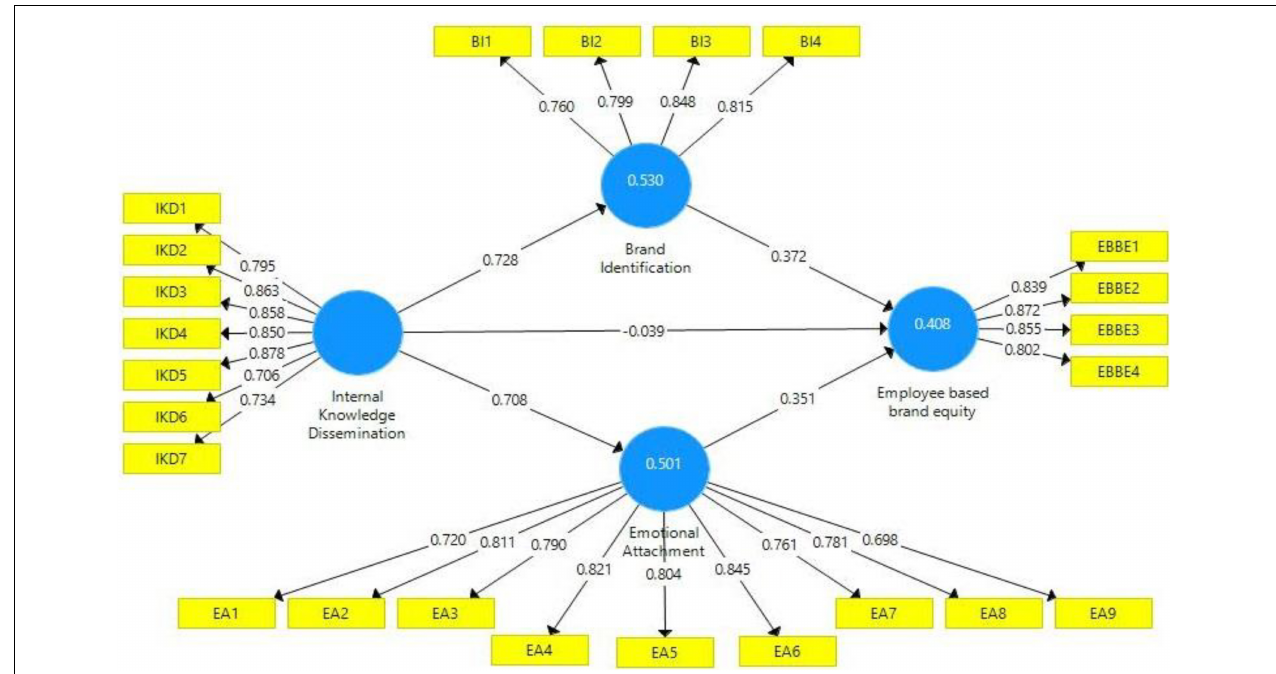
FIGURE 2 | Path estimates.